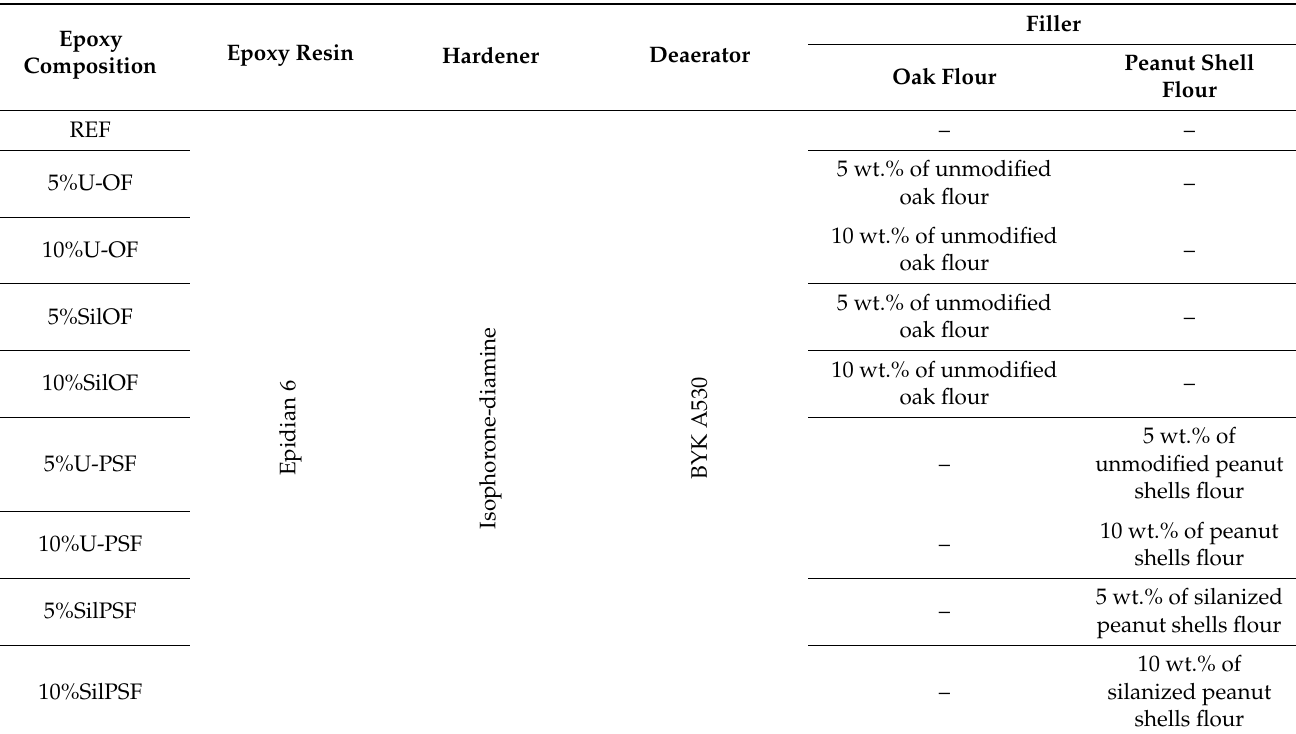
Table 2. Composition of epoxy